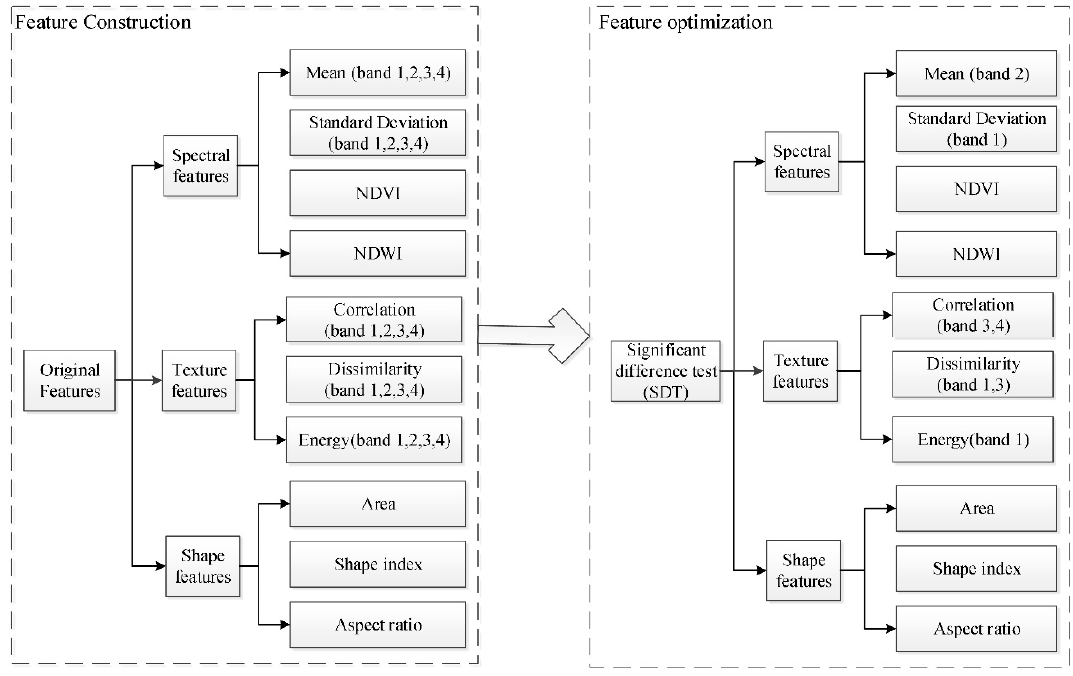
Figure 11. The processes of selecting the optimal features.